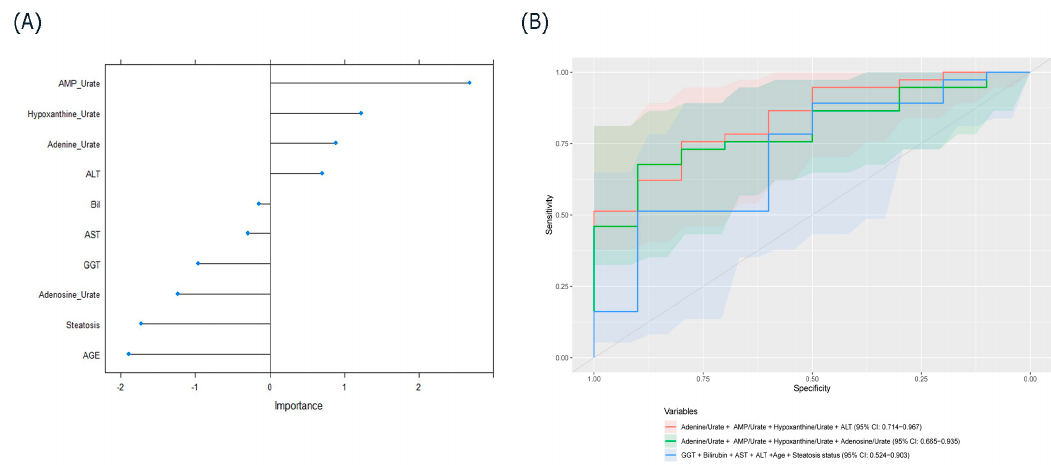
Figure 2. ( A ) Variable-importance plot derived from the random forest model. ( B ) Receiver operating characteristic (ROC) curve prediction of EGF based on the highest areas under the curve (AUC) with the combination of either clinical variables or metabolite ratios and the combination of metabolites and clinical variables. ALT, alanine aminotransferase; BiL, bilirubin; AST, aspartate aminotransferase; GGT, gamma-glutamyl transferase.